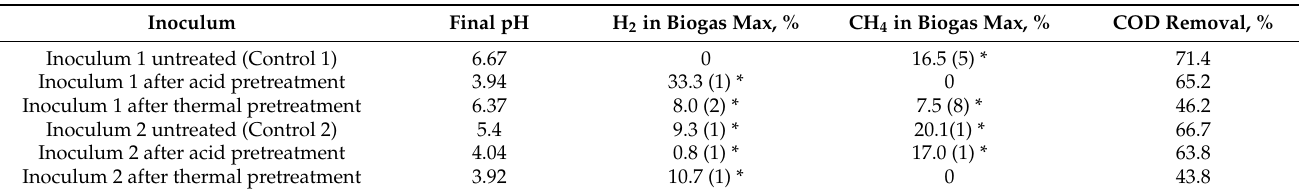
Table 2. Characteristics of batch dark fermentation of cheese whey using acid and heat pretreated inoculums. Inoculum Final pH H 2 in Biogas Max, % CH 4 in Biogas Max, % COD Removal, % Inoculum 1 untreated (Control